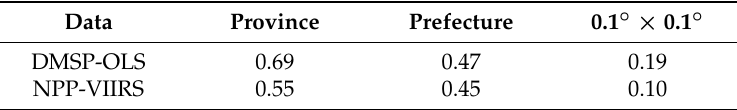
Table 2. R 2 of TNL-CO 2 regression at different levels.